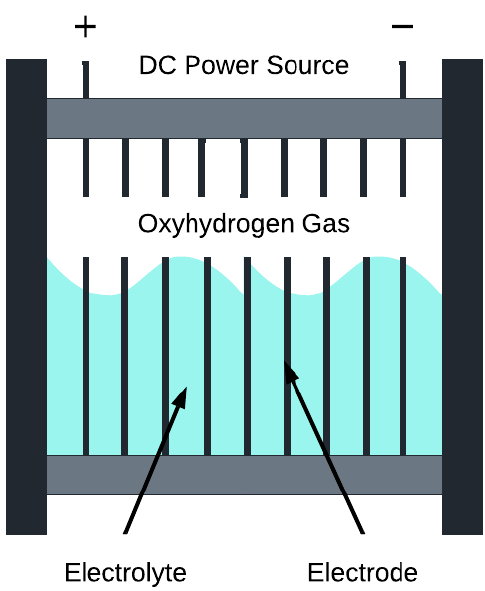
Figure 1. Scheme of a dry cell. Adapted from [8].